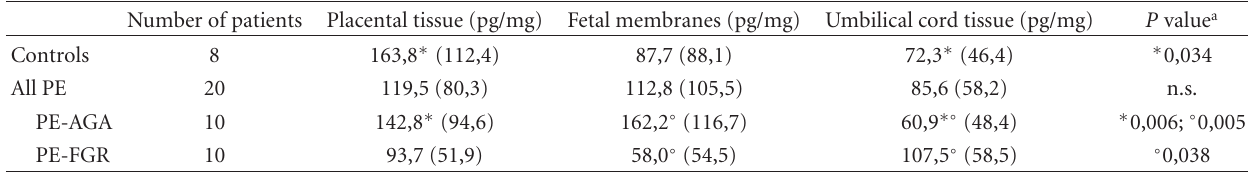
Table 2: Concentration of MIF in normal and pathological